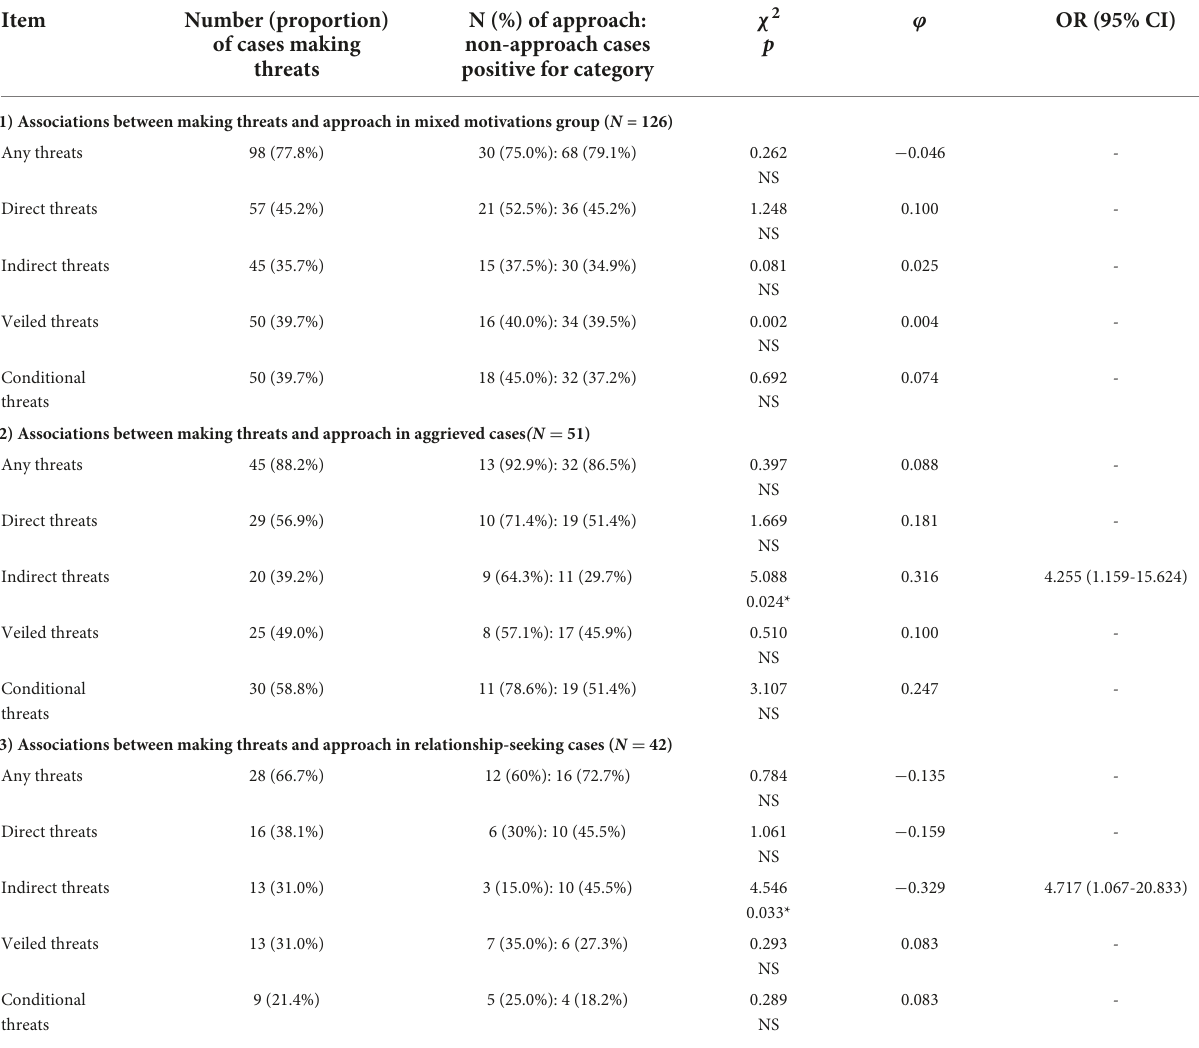
TABLE 3 Associations between threats and threat types and approach in the mixed motivations group, the aggrieved and relationship seekers. Item Number (proportion) N (%) of approach: of cases making non-approach cases threats positive for